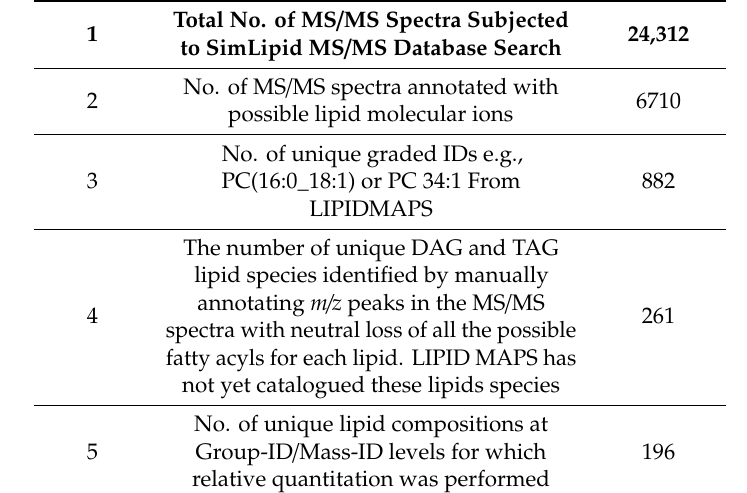
Table 1. Summary of the SimLipid MS / MS database search identified using 15 / 10 ppm error tolerances for precursor and product ions and grading the lipid molecular ions based on observed diagnostic ions in the MS / MS spectra using MS excel.